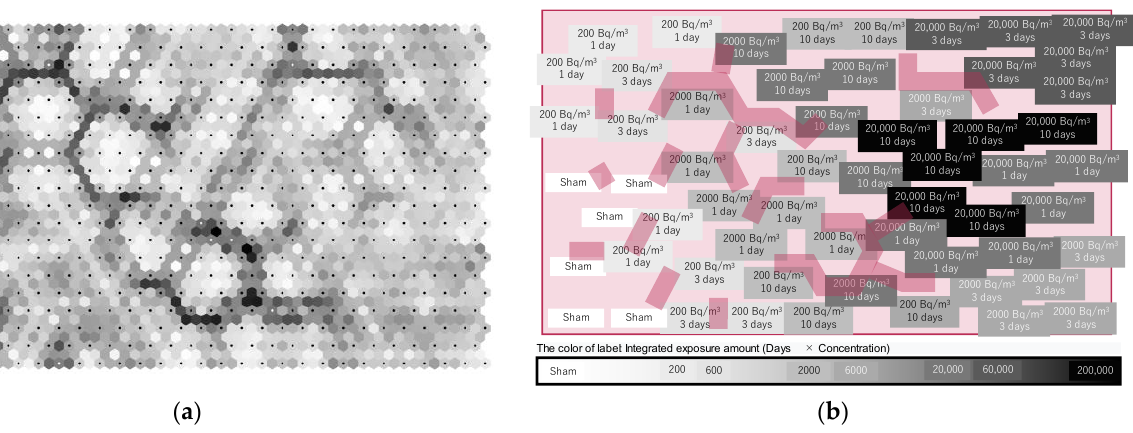
Figure 8. Feature extraction by SOM. ( a ) There were 600 hexagonal units, which had the data of the 27 detected metabolites on the output map. Units with similar patterns were placed into similar locations and a darker color unit was more different from the neighboring nodes. ( b ) The borderline and best matching units each with 60 input data (six mice per group in 10 groups) are shown on the conceptual diagram of the output map.